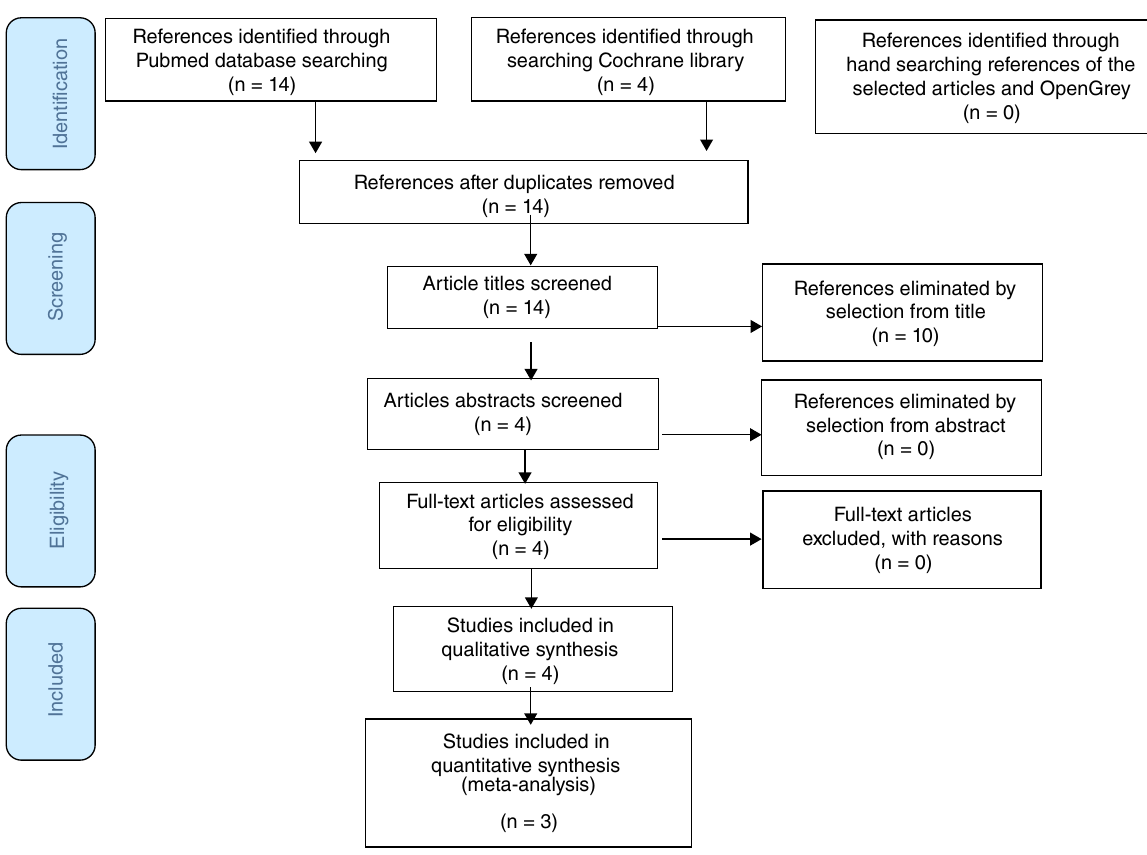
Figure 1. PRISMA Flow diagram. A list of included articles is shown in Table